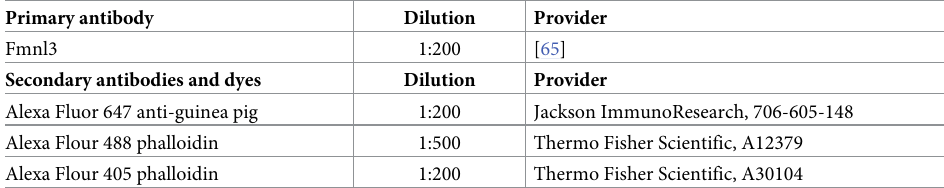
Table 1. Antibodies and dyes used for